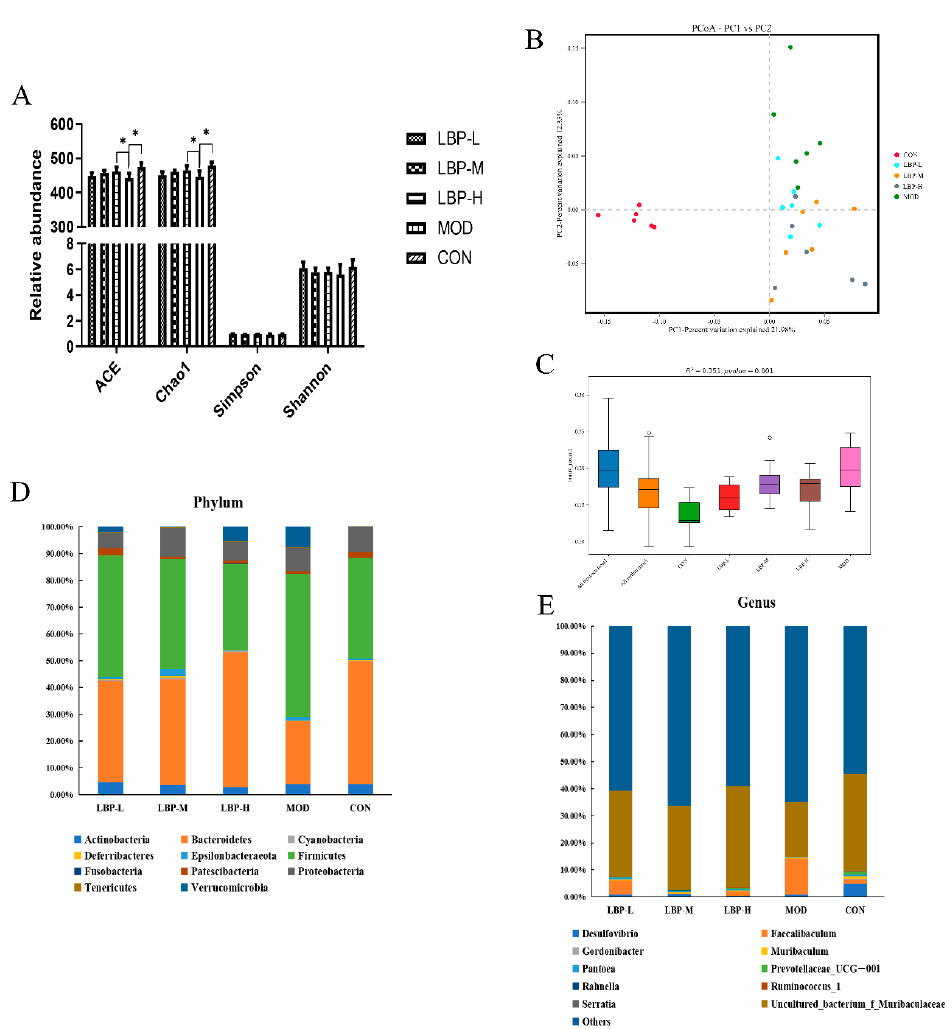
Figure 4. Effects of LBP feeding on fecal microbial diversity and composition by 16s rDNA Sequencing in high-fat diet induced obese mice. ( A ), ACE, Chao1, Simpson and Shannon indices, representing microbial richness and diversity; ( B ), PCoA analysis among five groups; ( C ), PERMANOVA analysis among five groups; ( D , E ), the distribution of fecal microbiota at the phylum and genus levels, respectively. LBP, Lycium barbarum polysaccharide; PCoA, principal coordinate analysis. *, p < 0.05, compared with the model group (MOD). Sample size for each group = 6.